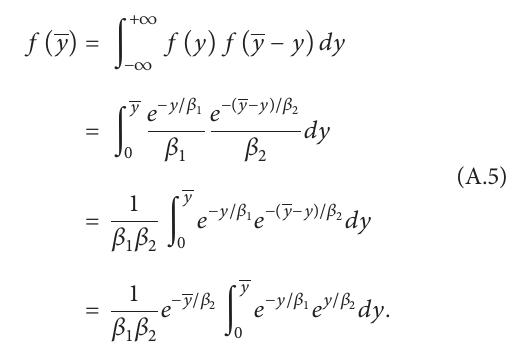
transmit and receive antenna sets cooperatively. And it